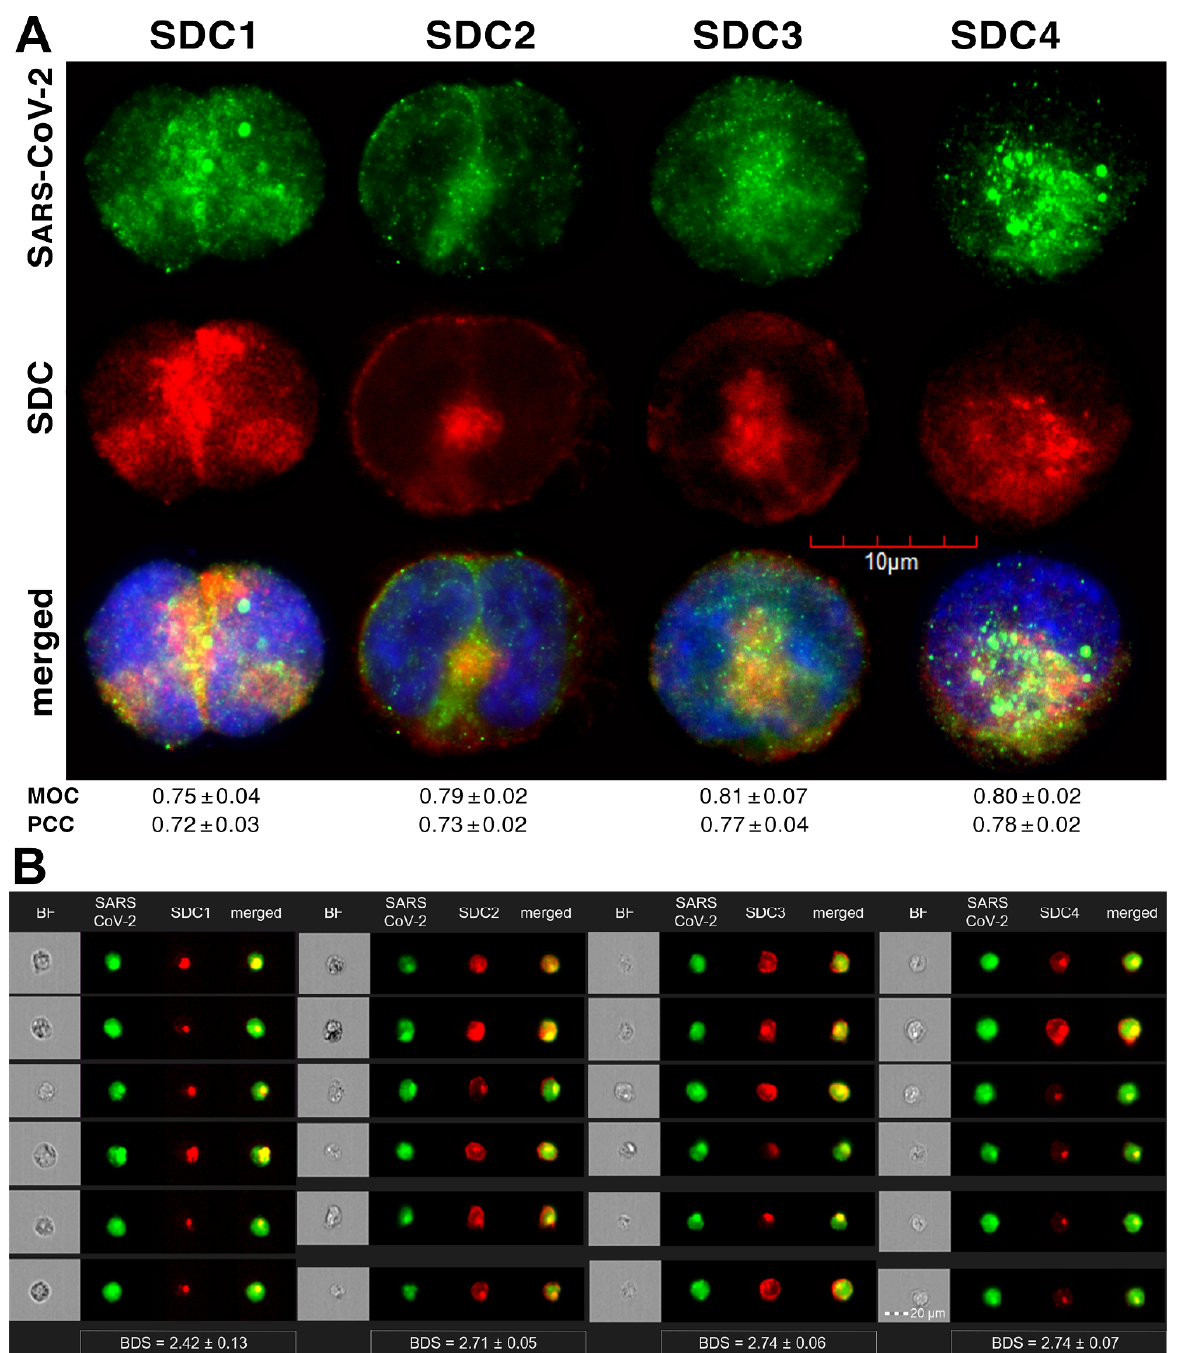
Figure 2. SARS-CoV-2 colocalizes with SDCs during cellular entry. WT K562 cells and SDC transfectants were incubated with heat-inactivated SARS-CoV-2 (at 1 MOI) for 18 h at 37 °C. After incubation, the cells were washed, trypsinized, fixed, permeabilized and treated with antibodies specific for the spike glycoprotein (along with secondary AF 488-labeled antibodies) and APC-labeled SDC antibodies. Colocalization of SARS-CoV-2 with SDCs was analyzed with confocal microscopy and imaging flow cytometry. ( A ) Microscopic analyses of SARS-CoV-2 and SDC colocalization. Representative images of three independent experiments are shown. Scale bar = 10 μm. The MOC and PCC ± SEM for the overlap and colocalization of SDC with SARS-CoV-2 (indicated below the images) were calculated by analyzing 15 images with an average of 10 cells in each image (from 3 separate samples). ( B ) BF and fluorescent images of SARS-CoV-2-treated SDC transfectants. Scale bar = 20 μm. The indicated BDS values of SARS-CoV-2 and SDCs represent mean ± SEM of four independent experiments.